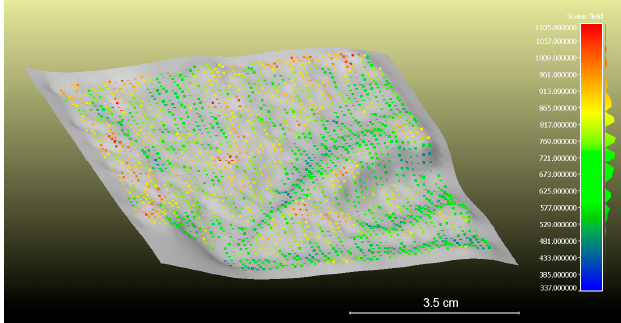
Figure 4. A sample of Acer platanoides L. with a surface constructed from the point cloud from the FARO X330, and the points with the raw intensity values, illustrating the curvy wrinkled characteristics of a leaf surface measured with a terrestrial laser scanner.